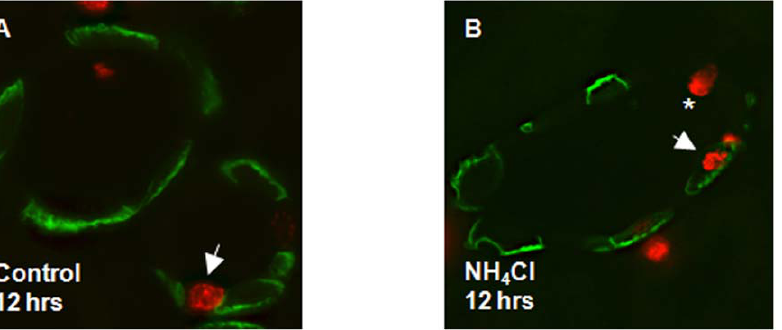
Figure 2. Early proliferation during induction and adaption to metabolic acidosis. Appearance of PCNA positive type A intercalated cells during acidosis. Kidney sections were stained with antibodies against either the type A intercalated cell specific AE1 protein (green), or the non-type A intercalated cell specific pendrin protein (red, asterisk), and antibodies against PCNA (red nuclei). ( A ) In the OMCD, PCNA labelling was seen in single cells not stained for AE1 under control conditions (arrow). ( B ) Co-staining of PCNA was seen in a few AE1 positive cells in the OMCD after 12 hrs NH 4 Cl-loading (arrow).